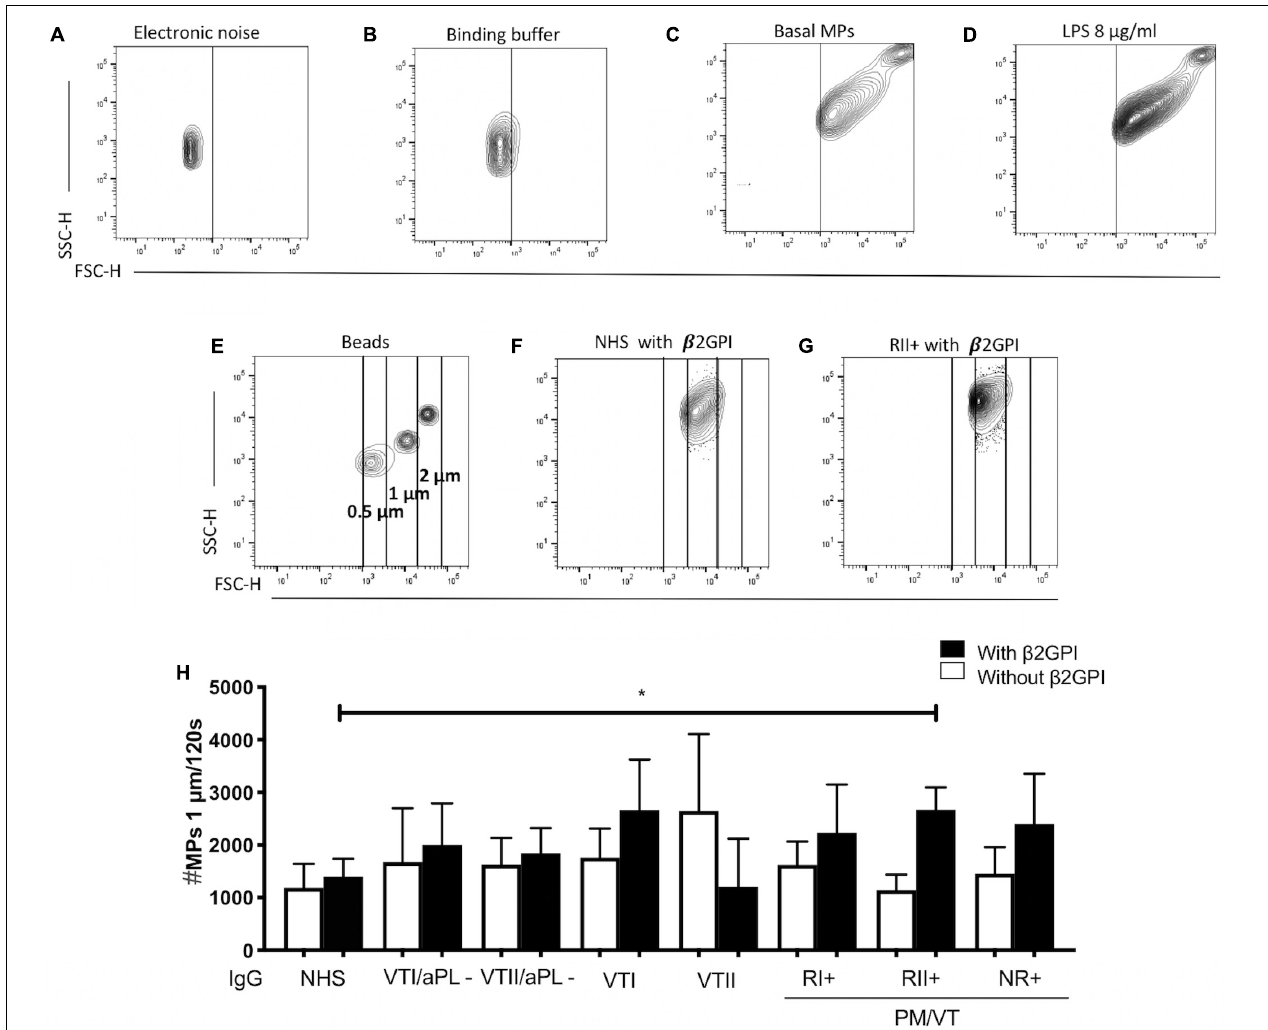
FIGURE 4 | Immunoglobulin-G from patients with secondary refractory APS (RII+) increased the number of 1- µ m microparticles (MPs). (A) Electronic noise was excluded from all the analyses. (B) The binding buffer for annexin V staining did not present a significant number of events. (C,D) LPS stimulation increased the number of MPs compared with no stimulation. (E) For all the analyses, the approximate size of the MPs was delimited with 0. 5-, 1-, and 2- µ m beads. (F–H) IgG of patients with RII + induced the generation of 1- µ m MPs in a β 2GPI-dependent manner compared with IgG from NHS control. A two-way ANOVA and the Holm–Sidak post-test (* p < 0.05) were performed. The results were obtained from three independent experiments. PM/VT, pregnancy morbidity and vascular